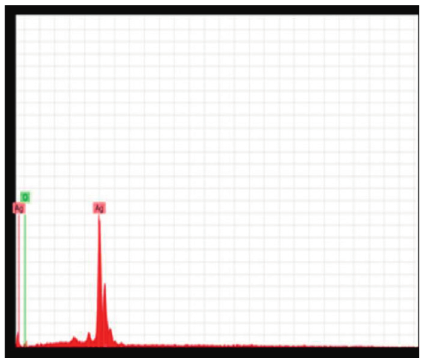
Figure 5: EDX graph of AgNPs synthesized using B. lanzan Spreng leaf